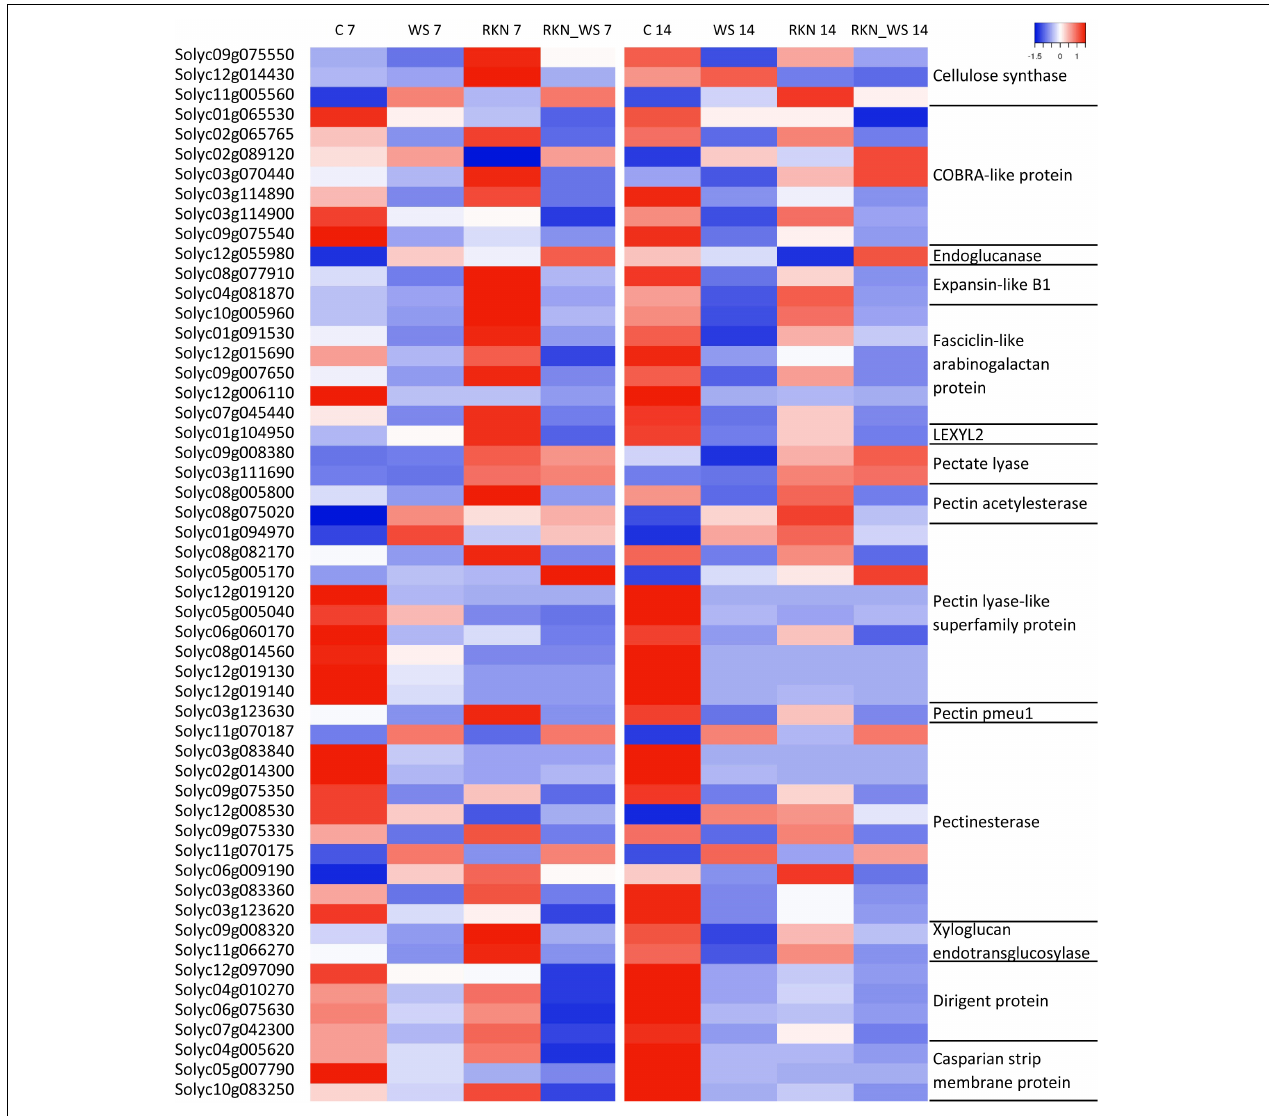
FIGURE 6 | Gene expression patterns of subsets of DEGs associated with cell wall in tomato. The heatmap represents TPM mean values of subsets selected in water stressed roots inoculated with M. incognita (RKN_WS) with statistically significant differences ( p -value ≤ 0.05) for almost one condition. Each row represents a gene, and each column represents an experimental condition at 7 and 14 dpi. Labels on the left and right sides of the heatmap show the Solyc id and annotation, respectively. The color key scale values range from –1 (lowest TPM number) to 1 (highest TPM